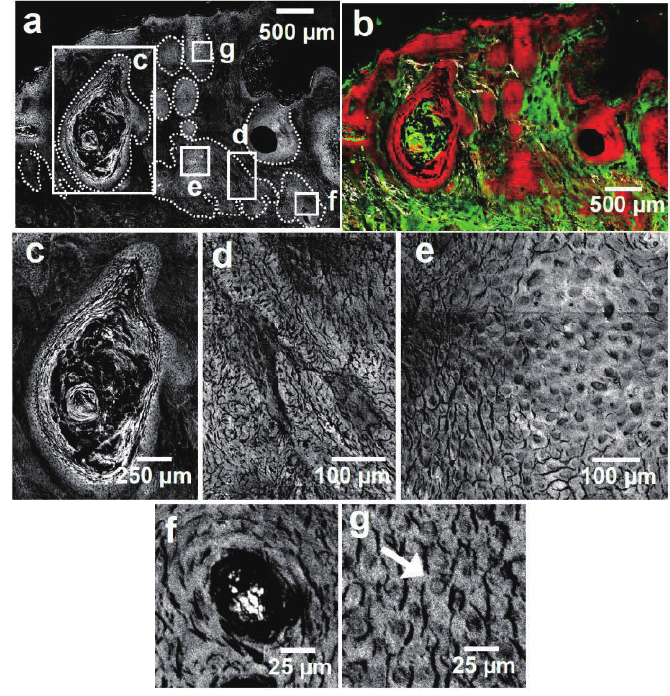
Figure 5. CARS (gray scale) and multimodal image (CARS: red, TPEF: green, SHG: grays) detail taken of Figure 4a,d. ( a ) and ( b ) CARS and multimodal image section illustrating the tumorous region, which is located by the dotted line; ( c ) Keratinizing tumor; ( d ) SCC tumor nest. The tumorous cells can be discerned from the embedding dermal tissue; ( e ) Tumor cells with pleomorphic nuclei; ( f ) Keratin pearl; ( g ) SCC cells. The white arrow points towards a nucleus appearing dark in CARS. Compared to non-cancerous tissue (see Figure 3f) the tumorous tissue possesses an increased cell density, larger nuclei and therefore an elevated nuclear cytoplasm